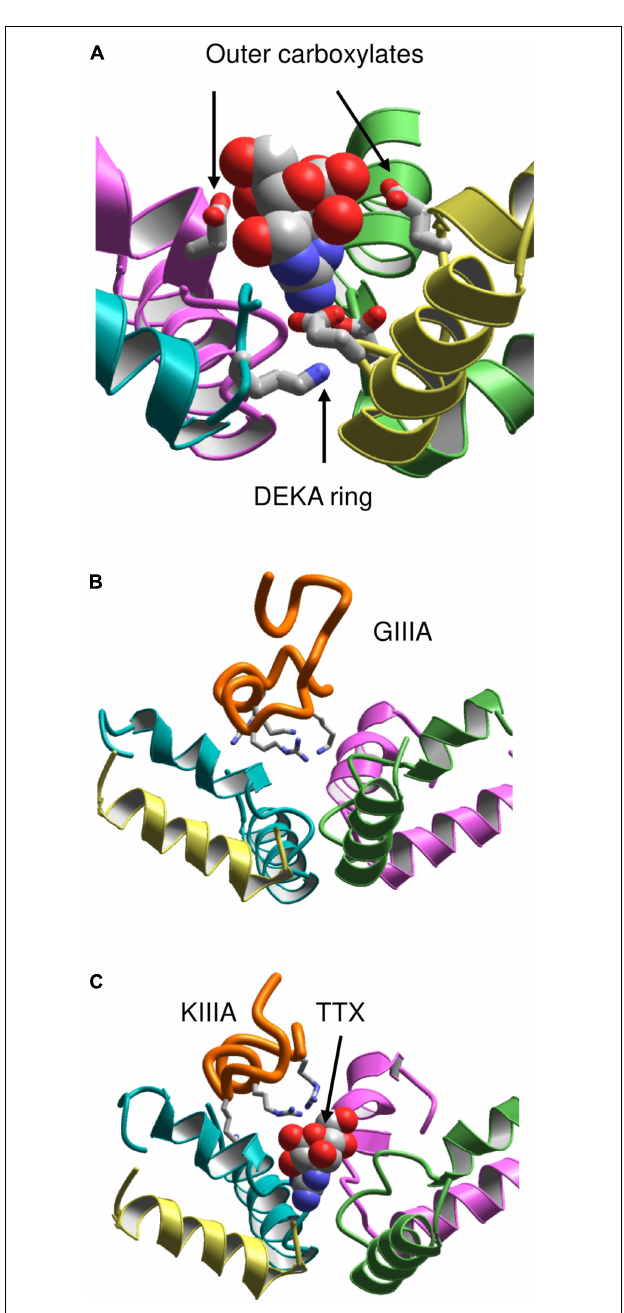
FIGURE 4 | Toxins in the NavAb-based models of Nav1.4. (A) TTX fits between the DEKA ring and the outer carboxylates (Tikhonov and Zhorov, 2012). Helix P2 in repeat III is removed for clarity. (B) µ -CTX GIIIA (orange) binds in the wide outer vestibule and positively charged toxin residues